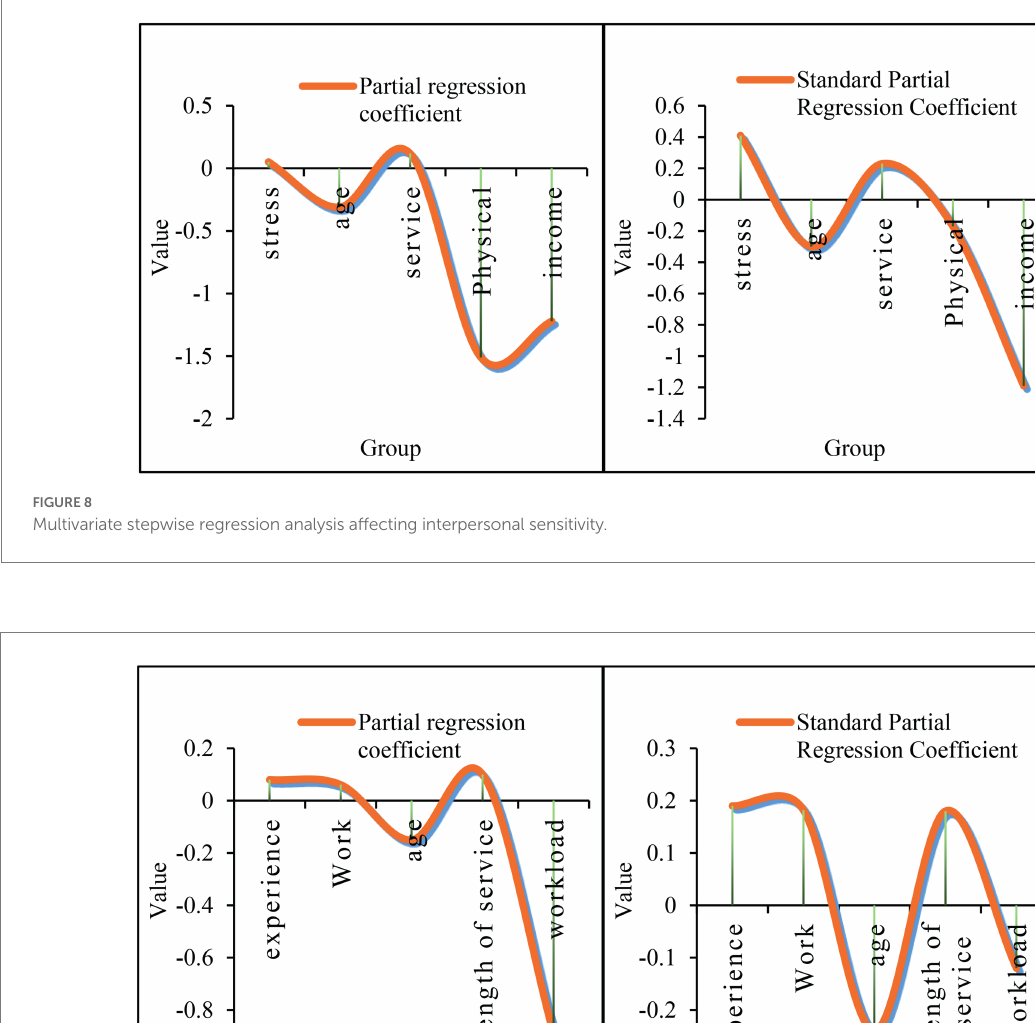
hostility, that is, the older the age, the weaker the personal hostility. The length of service index is 0.1, indicating that the length of service is proportional to the hostility. The task volume index is-0.89, indicating that the task volume and hostility are inversely proportional. When the individual’s task volume increases, the focus is more focused, and the less hostile elements are considered. According to the above situation, the relevant workload can be reasonably increased to reduce the hostility of employees. According to the standard partial regression coefficient, the age coefficient is-0.24, and the workload index is-0.12. According to its absolute value, age has the greatest influence on hostile psychology, and the amount of tasks has the least influence on hostile psychology.